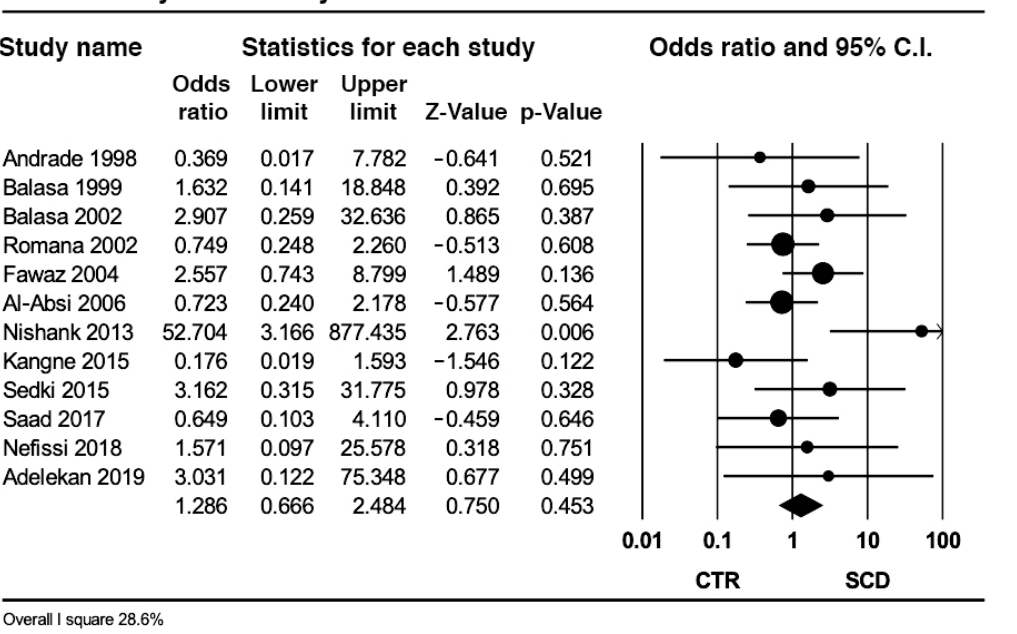
Figure 4. Effect size of the pooled prevalence of the methylenetetrahydrofolate reductase TT in controls and in sickle cell disease.